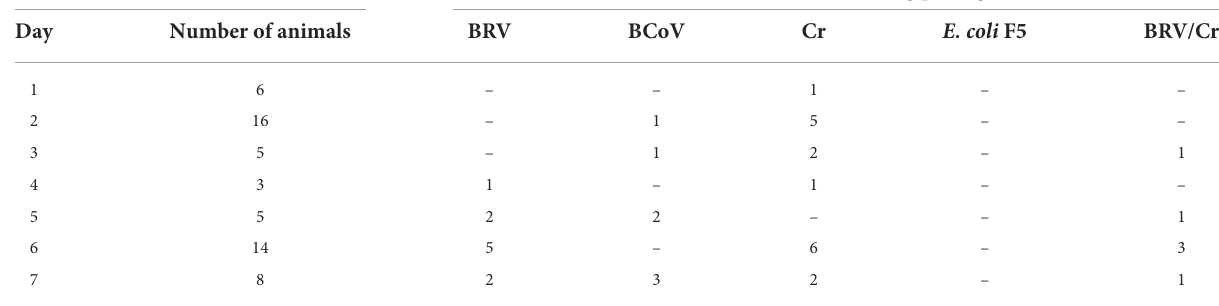
TABLE 1 Detection of common pathogens in the feces of diarrheic calves ( n = 57) using ELISA (BIO K 348) at different times after birth. Onset of